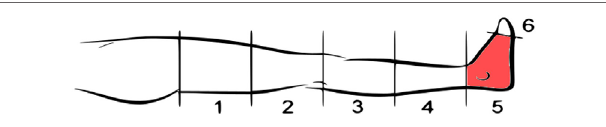
FigUre 3 | Representation of the phantom limb pain location in the lower-limb amputee subject treated with phantom motor execution .